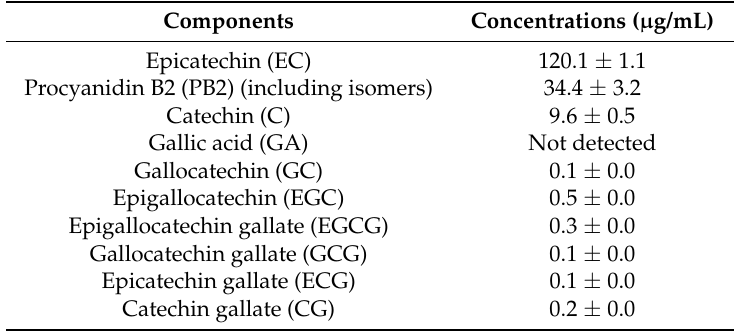
Table 2. Concentrations of catechins, procyanidin B2, and gallic acid in CLE solution (400 µ g/mL).